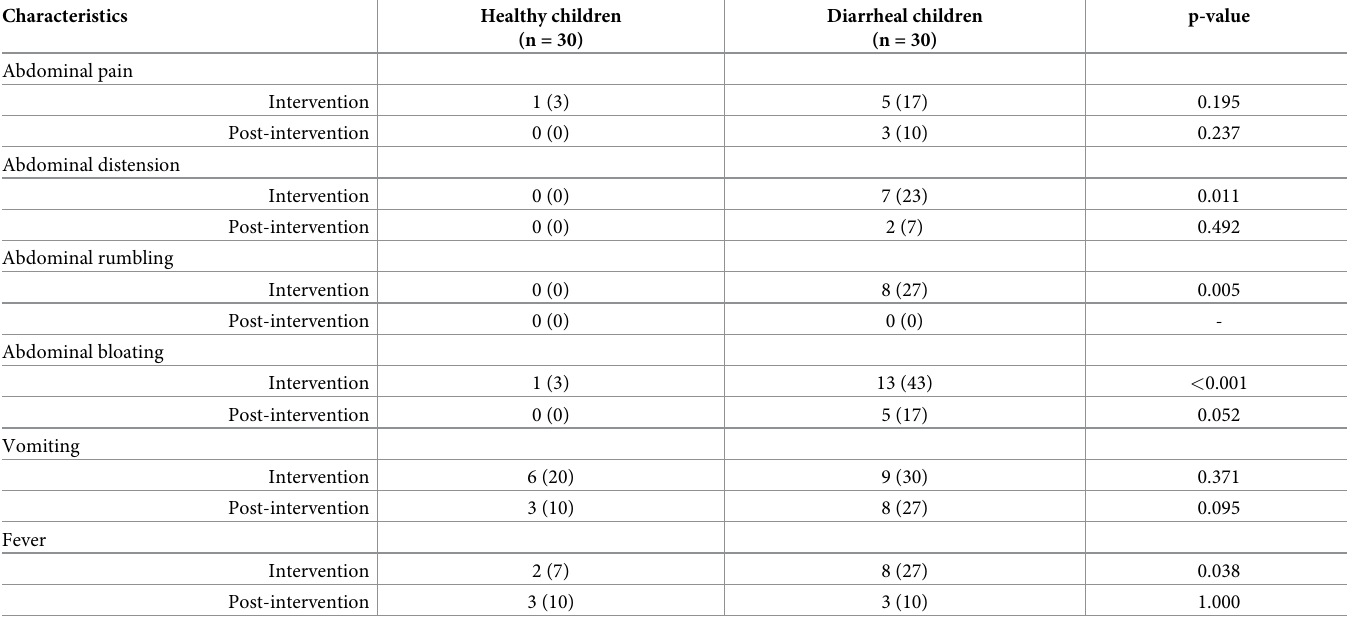
Table 4. Comparison of characteristics between healthy and diarrheal children during intervention and post-intervention period.